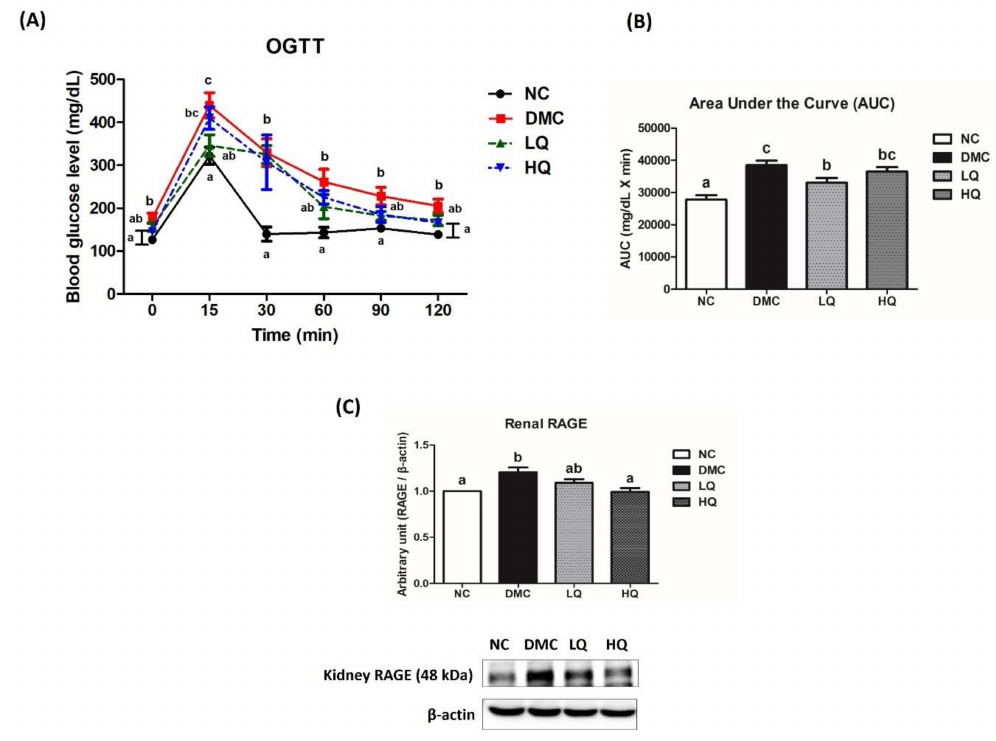
Figure 1. E ff ect of QAE on ( A ) glucose tolerance, ( B ) glucose area under the curve (AUC), and ( C ) renal receptor of AGE (RAGE) in T2DM mice. Data were expressed as means ± SEM. Mean values with the same superscript letter are not significantly di ff erent ( p < 0.05). NC: Normal mice; DMC: Type 2 diabetic mice; LQ: Type 2 diabetic mice supplemented with a low dose (5 mg / kg / day) of QAE; HQ: Type 2 diabetic mice supplemented with a high dose (10 mg / kg / day) of